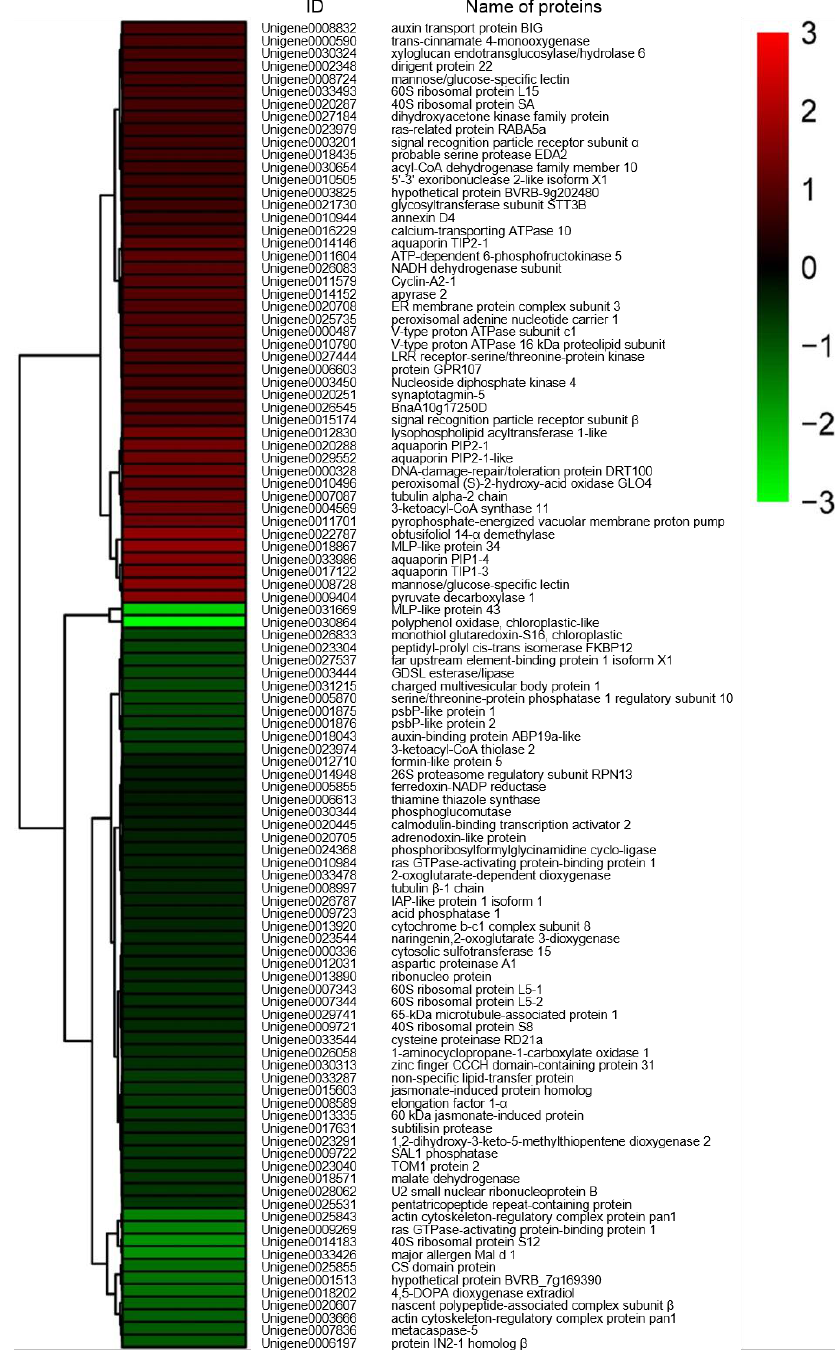
Figure 3. Heat map diagram of expression patterns for differentially expressed proteins in roots of salt-treated sugar beet plants compared with untreated plants. The color scale bar in the right, bottom corner indicates increased (red) and decreased (green) levels in response to salt